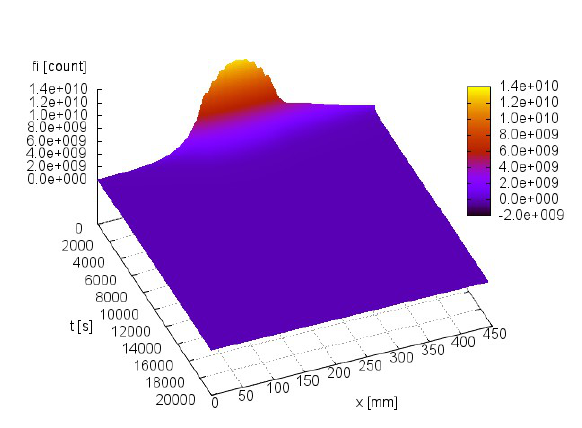
Figure 4. Neutron flux distribution for energy